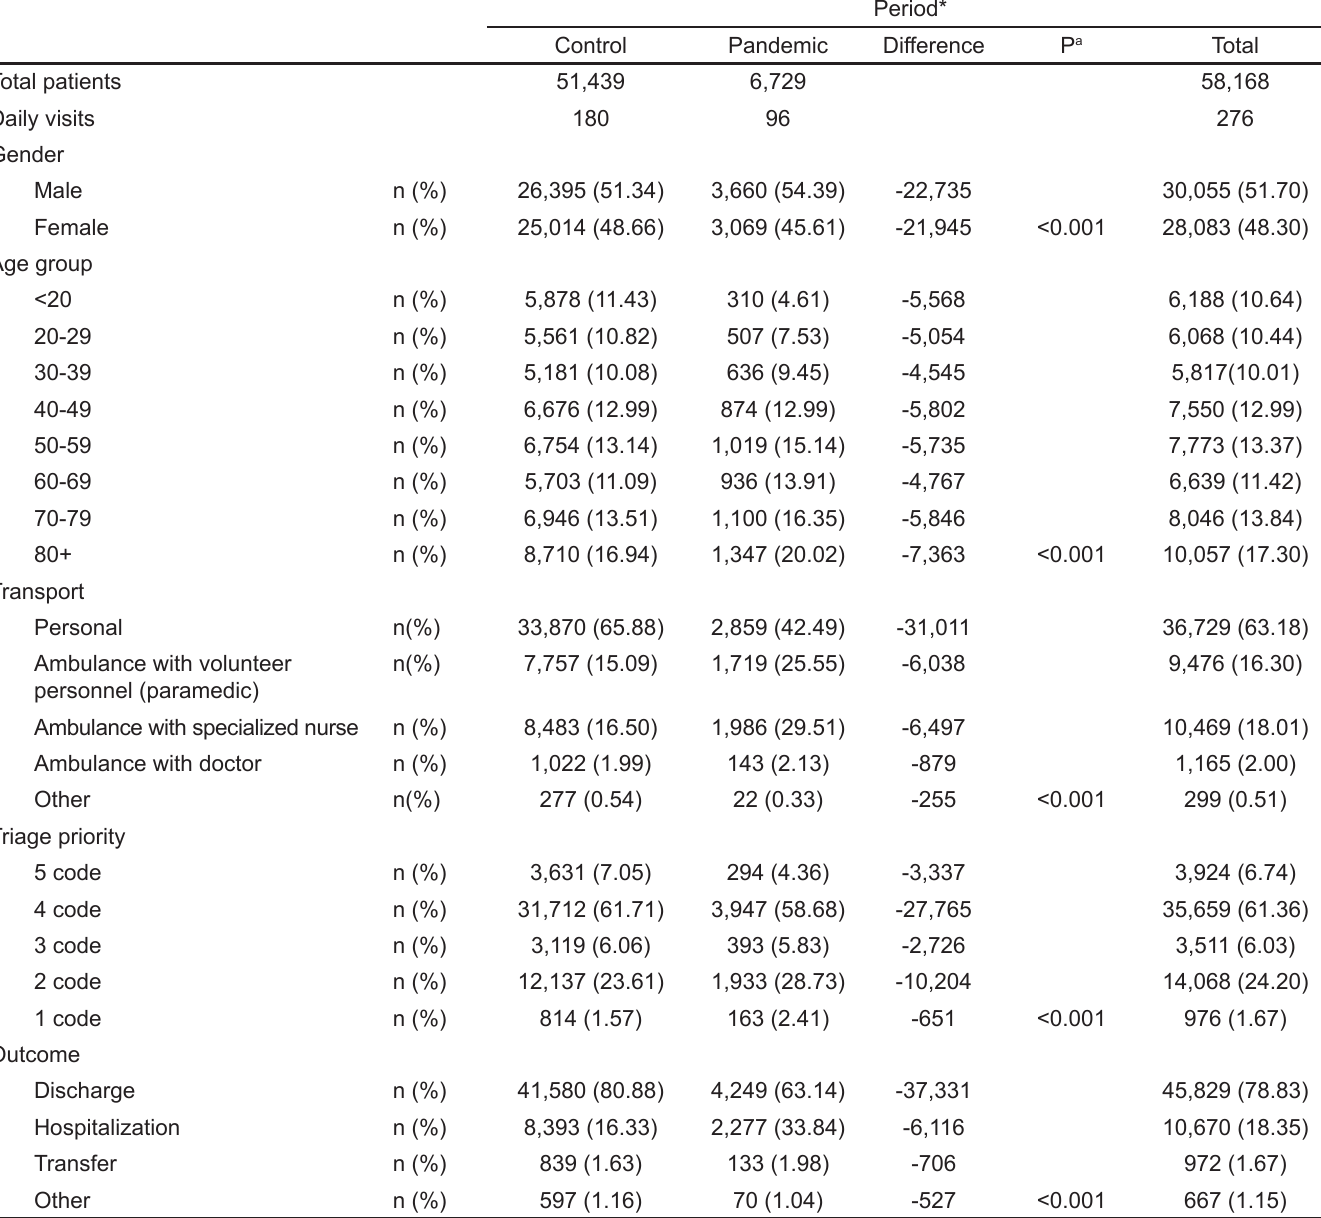
Table 1. Principal personal and emergency department presentation features of patients included in the study, by period of